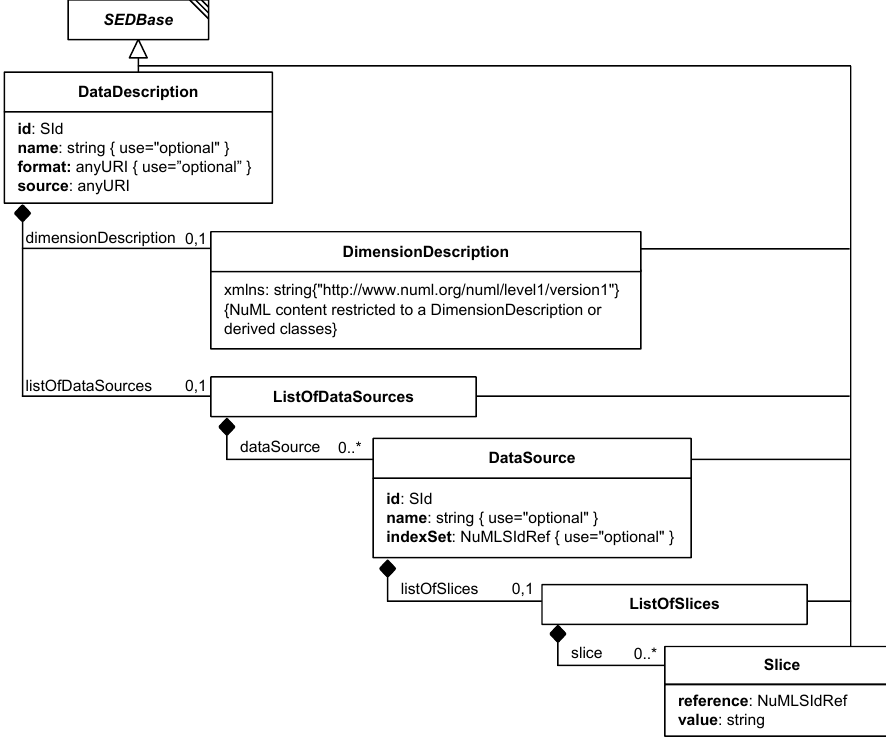
Figure 2.8: The SED-ML DataDescription